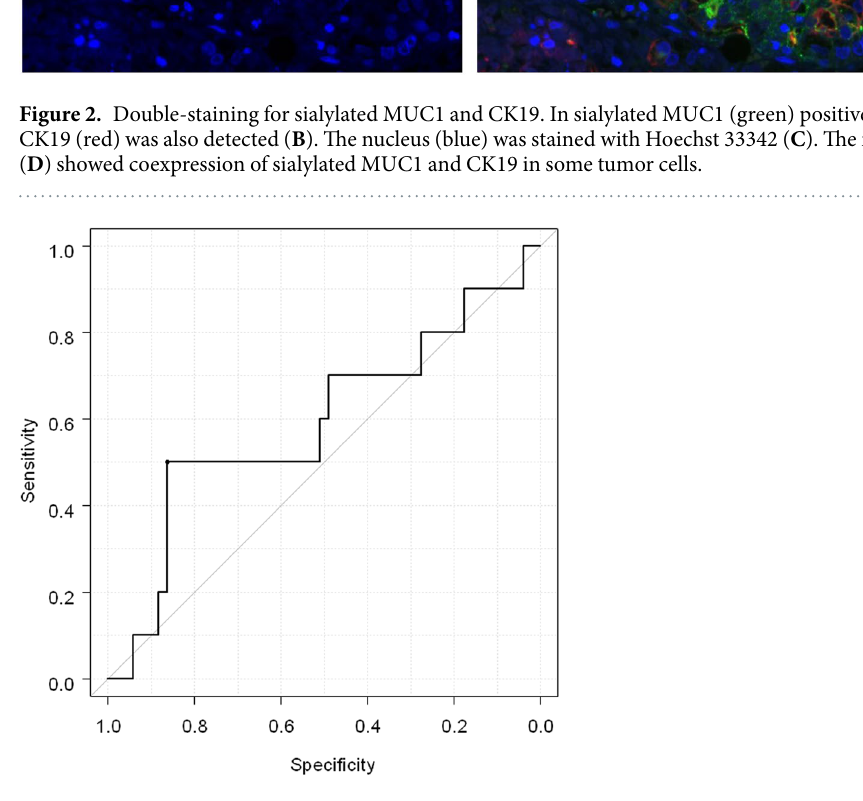
Figure 3. ROC analysis of serum WFA-sialylated MUC1 for detection of sialylated MUC1 positive